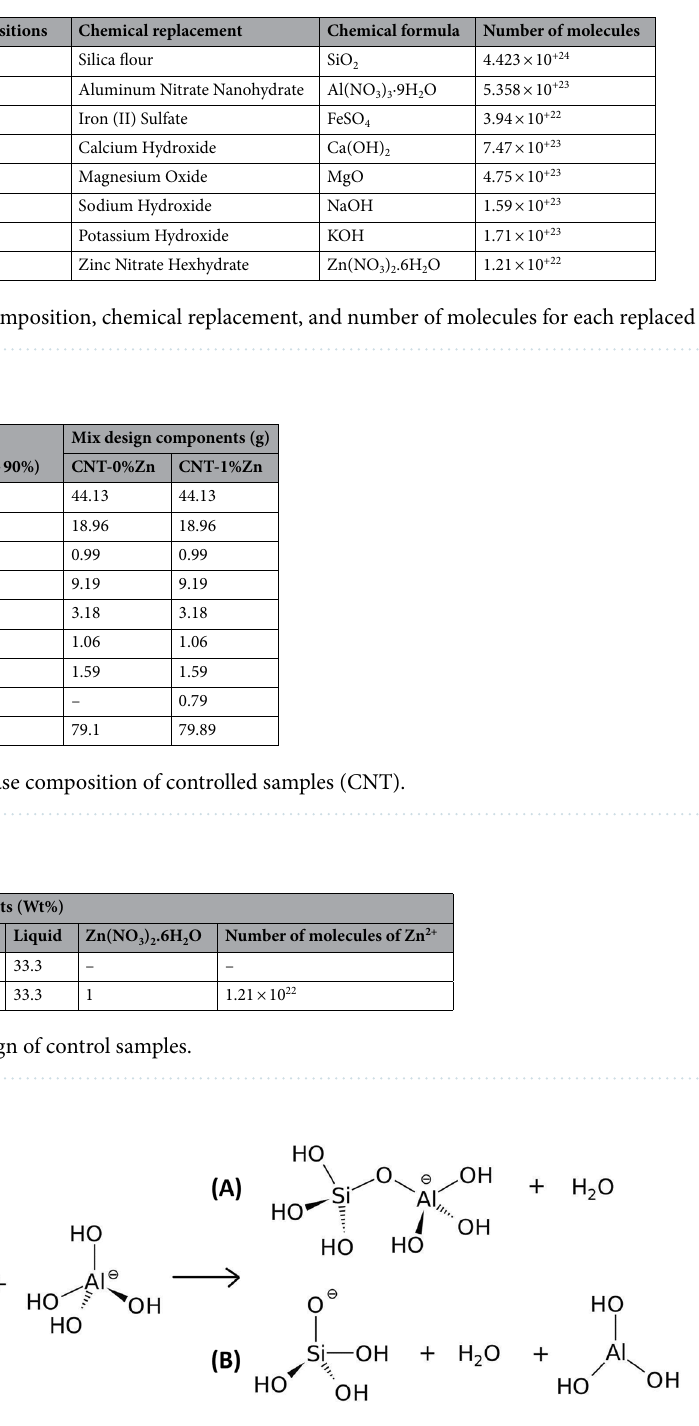
Figure 5. Dehydration reactions ( A ) with and ( B ) without condensation of the reactant